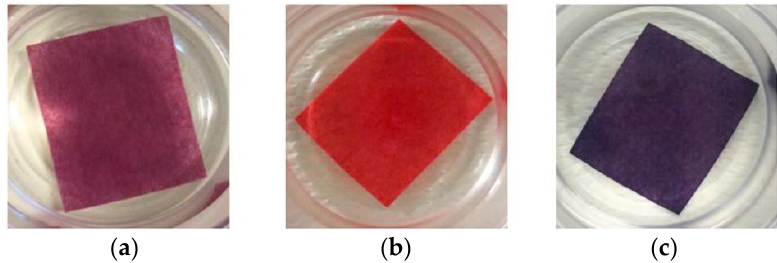
Figure 9. Colour change of Aliz-CC@ before ( a ), and after equilibration in Al(III) solution ( b ) or Fe(III) solution ( c ) [60].